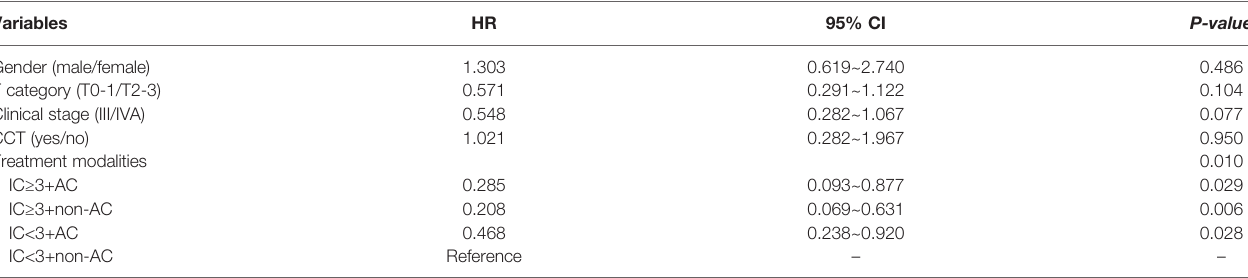
TABLE 4 | Multivariate Cox regression analysis of overall survival.